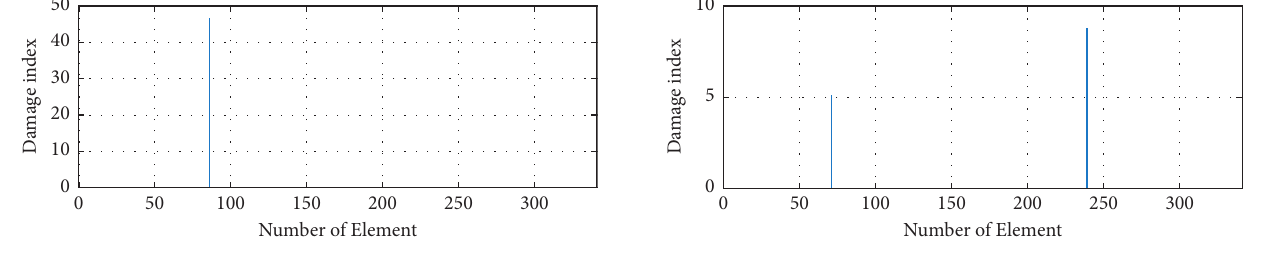
Figure 11: Results of D5 using MCA-DI (L-shape